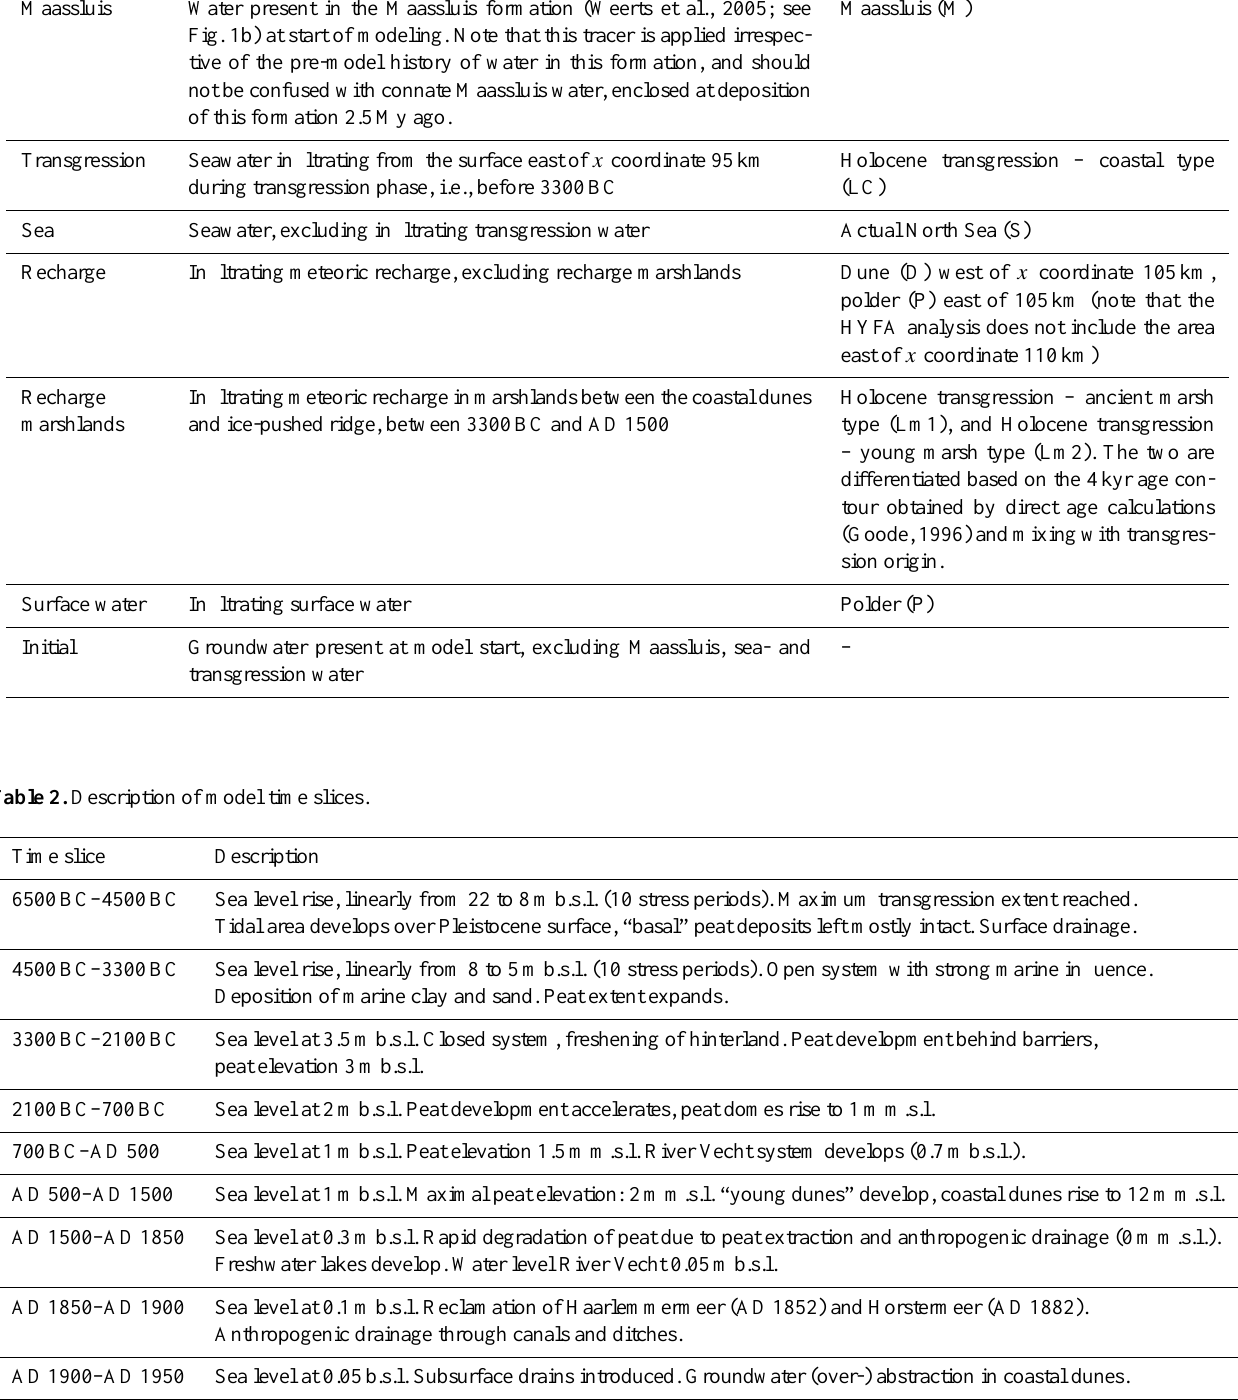
Table 1. Description of modeled origin tracers and relation to hydrosomes. Tracer